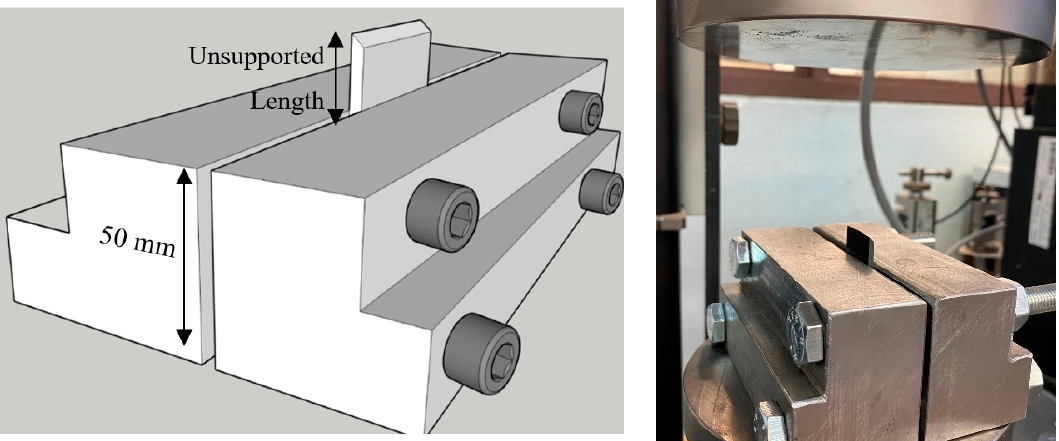
Figure 1. The illustration of the flat-plate specimen with the supporting fixture ( left ) and the test setup ( right ).